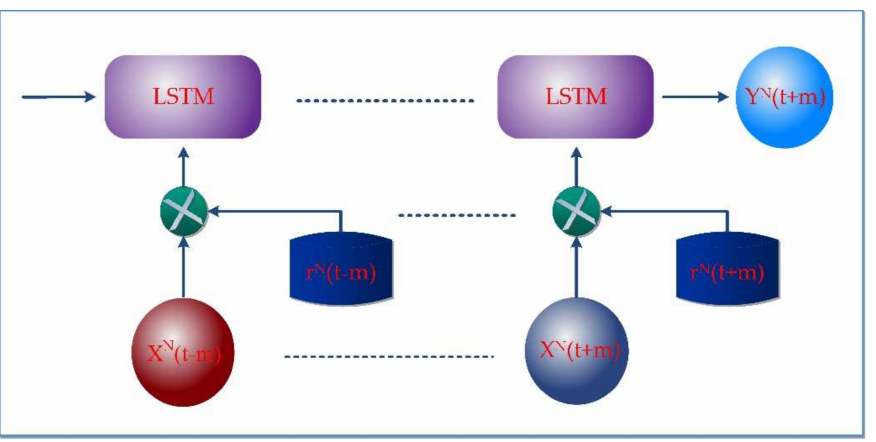
Figure 3. Adding of Adversarial